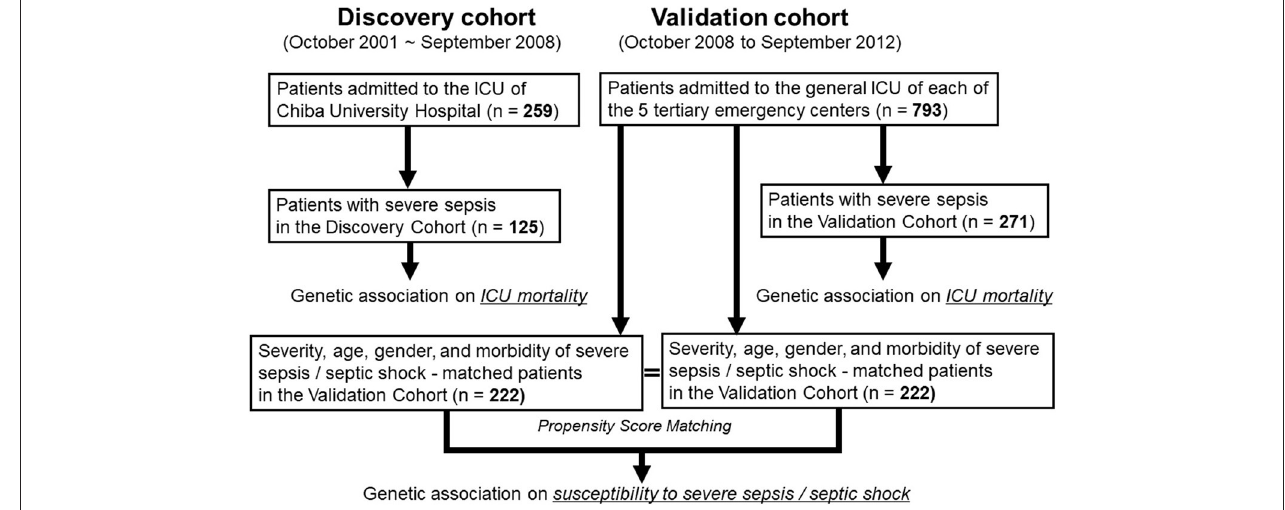
FIGURE 1 | Flow diagram of patient inclusion.